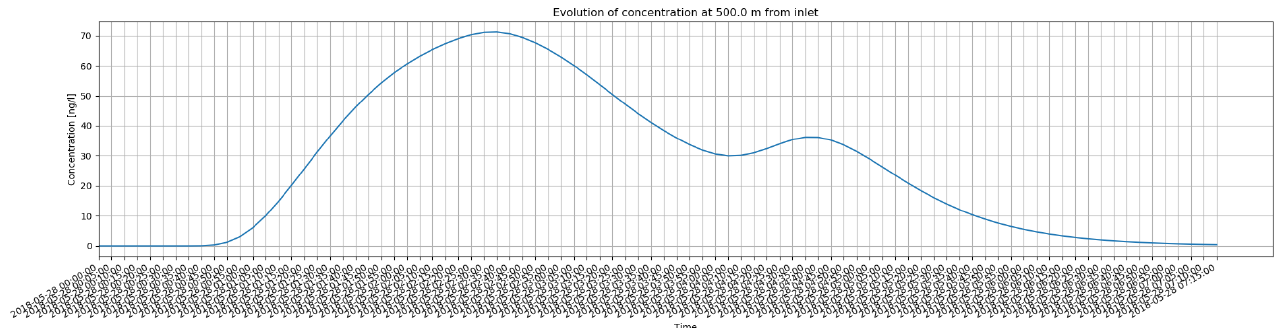
Figure 4. Example graph: solution at a selected point as function of time.